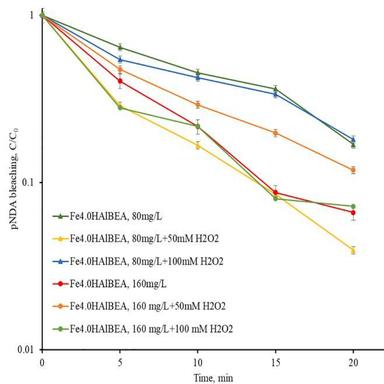
Bleaching of pNDA using the best identified zeolite material (Fe4.0HAlBEA) at zeolite loadings of 80 and 160 mg L− 1 with different hydrogen peroxide concentrations.